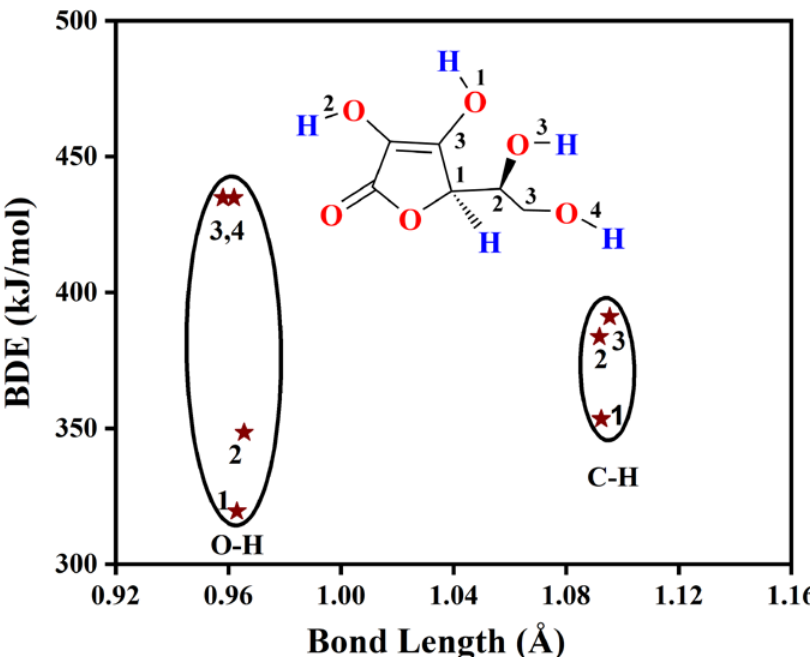
Figure 6. Bond dissociation enthalpy (BDE) vs. bond length plot for L-ascorbic acid (Asc) as natural antioxidant additive. The calculations have been carried out at the M06-2X/6-311++G(2d,2p) level of theory in gas phase.